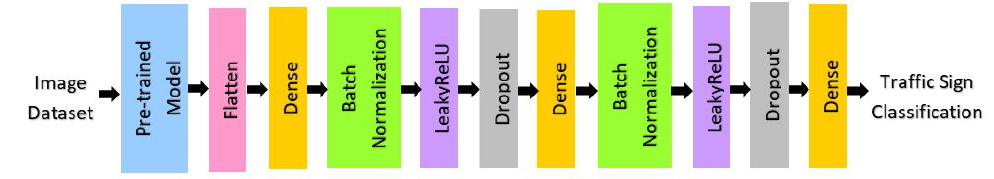
Figure 3. The architecture of the proposed CNN pre-trained